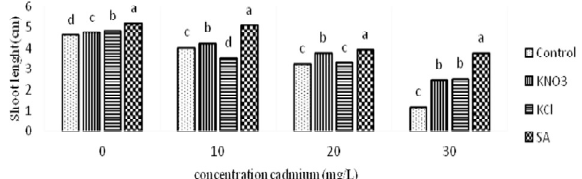
Fig. 3. Shoot length of unprimed (UPS) and primed (PS) seedling of fenugreek ( Trigonella foenum-graecum L.) under different Cd concentrations Shoot length was measured in unprimed seeds and when seeds were primed by 100 mg/L SA and -1 MPa KNO 3 and KCl solution for 24 hours. The unprimed seeds were used as the control. Means with similar letters were not significantly different (p ≤ 0.05) based on LSD